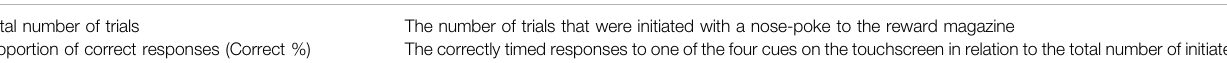
TABLE 1 | Parameters of the Iowa Gambling Task used for the analysis of the data. Parameter